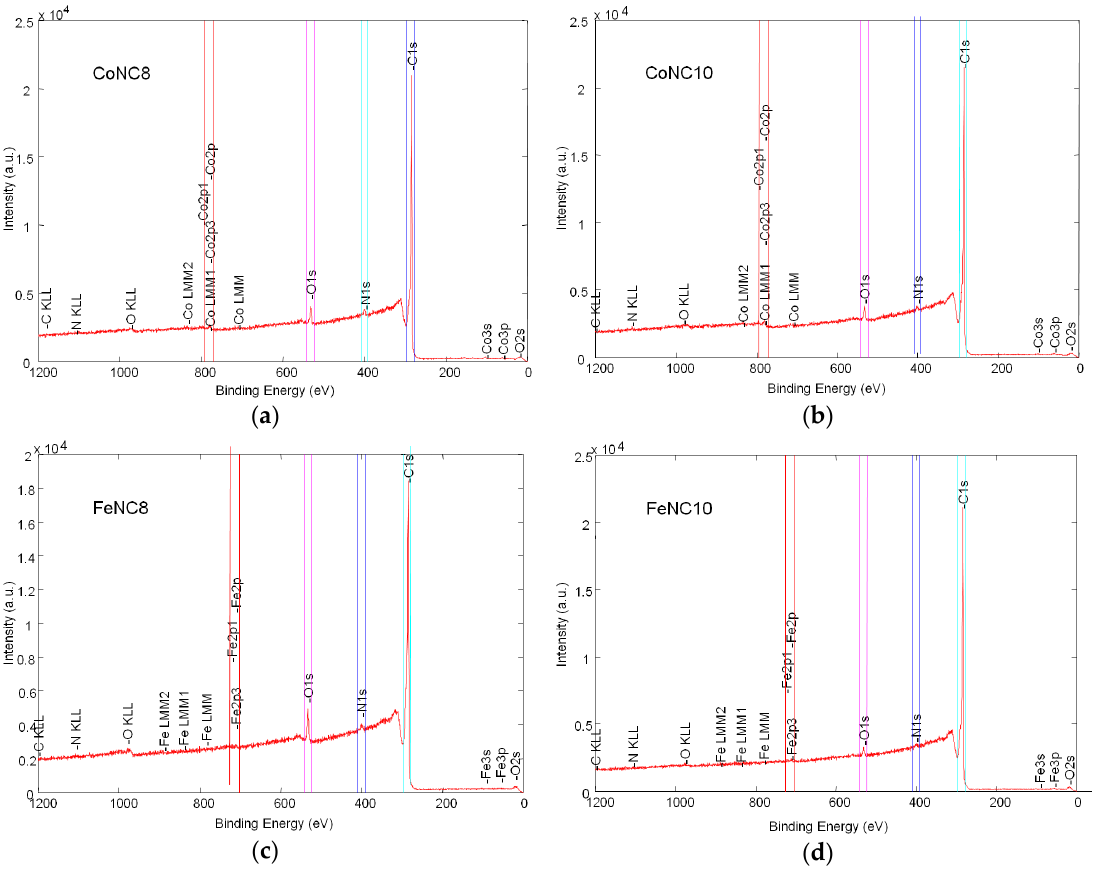
Figure 3. Survey X-ray photoelectron (XPS) spectra for the following catalysts: ( a ) CoNC8; ( b ) CoNC10; ( c ) FeNC8; and ( d ) FeNC10.